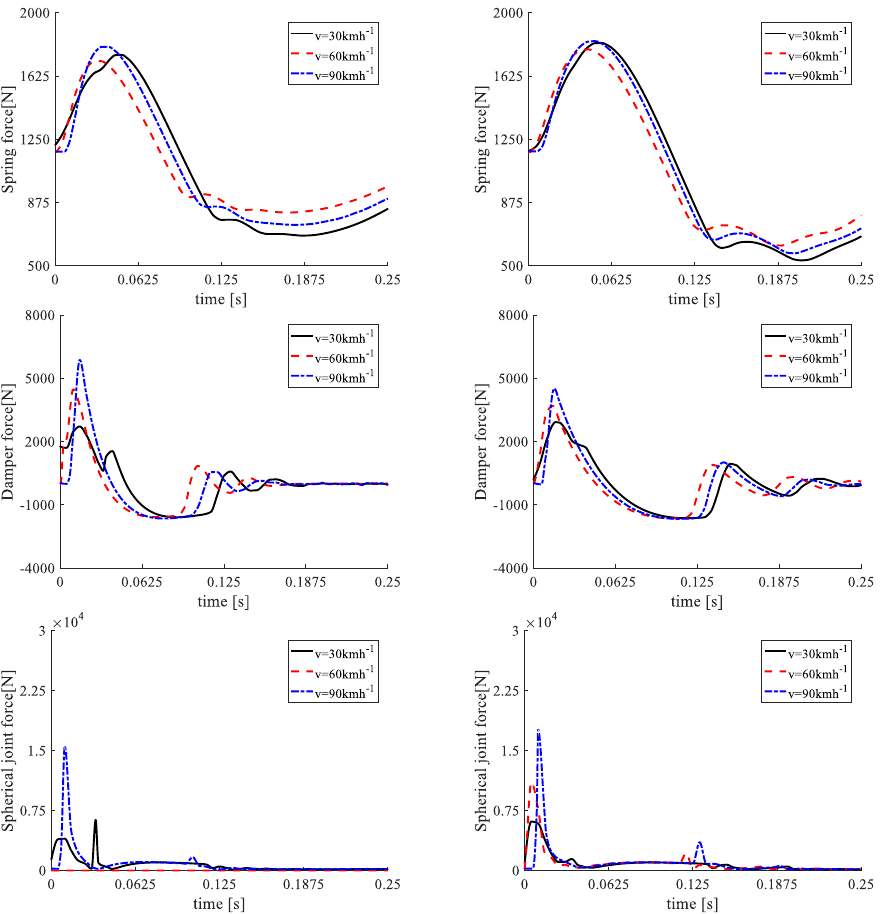
Figure 13. Selected time courses obtained for the suspension model with the rigid beam during overcoming the E-type obstacle.